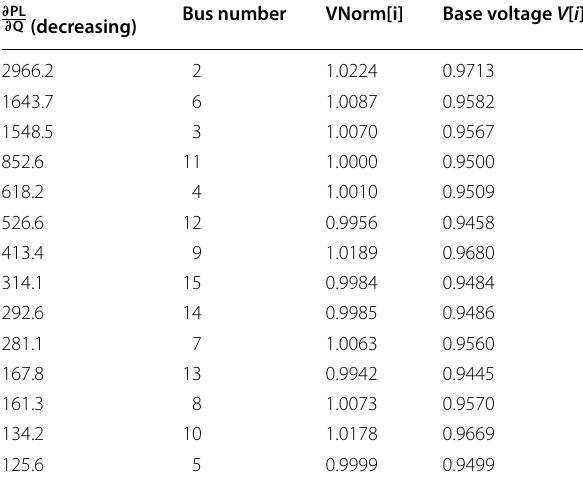
Table 1 Loss sensitivity factors for 15-bus system